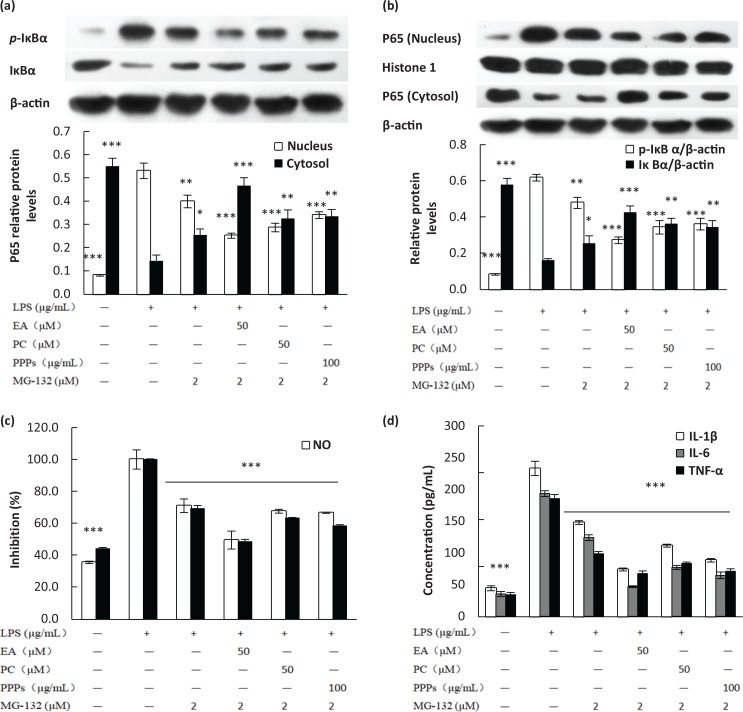
The effect of ubiquitin proteasome inhibitor on LPS-induced IκBα Ub-mediated degradation (a), NF-κB translocation (b), the production of NO/PGE2 (c), and pro-inflammatory cytokines (d) in RAW264.7 macrophages. Cells were pretreated with different concentrations of PPPs, PC, EA, or MG-132 (2 μM) for 1 h and then stimulated with LPS (1 μg/mL) for 20 min. The total lysates of the proteins were subjected to Western blot analysis, and the culture media were collected for NO and ELISA detections. Data are expressed as mean ± SD. *P < 0.05, **P < 0.01, and ***P < 0.001 compared with LPS-stimulated group.